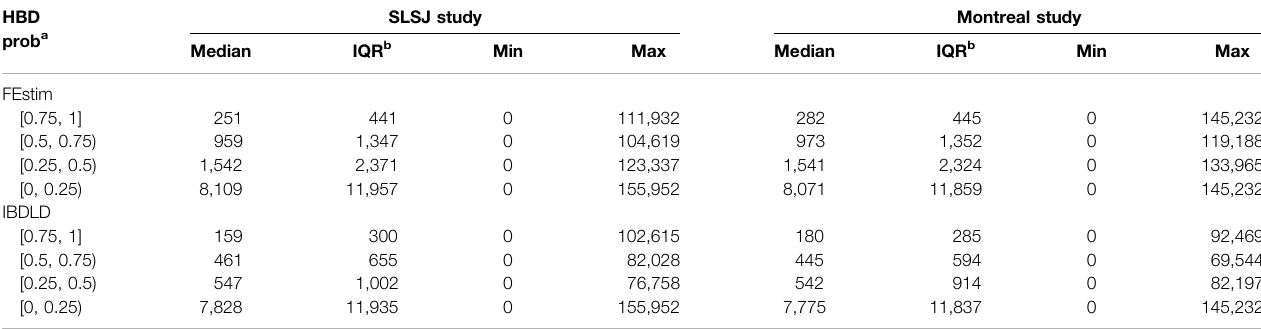
TABLE 1 | Summary statistics of the distributions of the time to coalescence (generations) captured by setting different cutoffs of HBD probability (from FEstim or IBDLD) to determine the HBD status of each SNP for each proband. SLSJ study Montreal HBD prob a